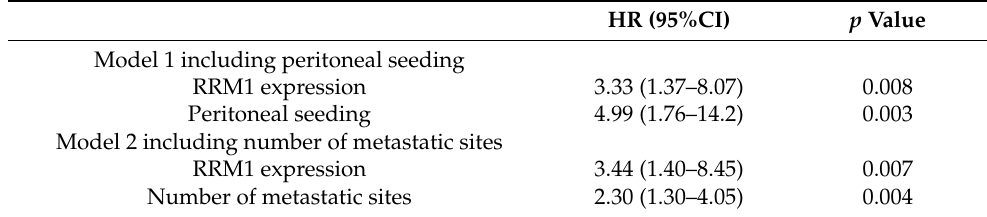
Table 3. Multivariate analysis for overall survival in RRM1 expression including peritoneal seeding or the number of metastatic